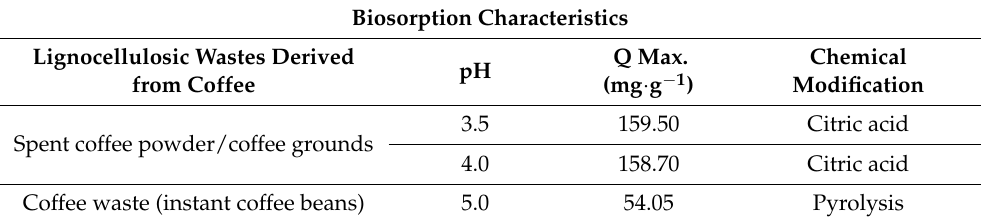
Table 14. Maximum adsorption capacity of chemically modified coffee waste. Own compilation based on literature data